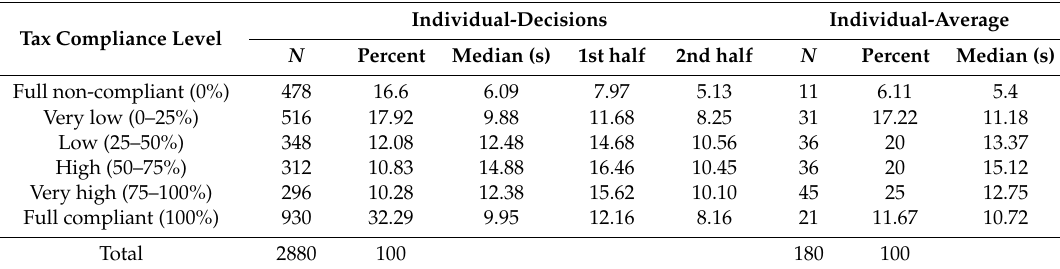
Table 1. Distribution of tax compliance level by decisions and